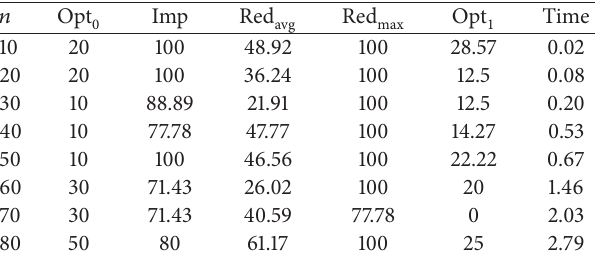
Table 11: Performance of the lower bounds for m = 5.